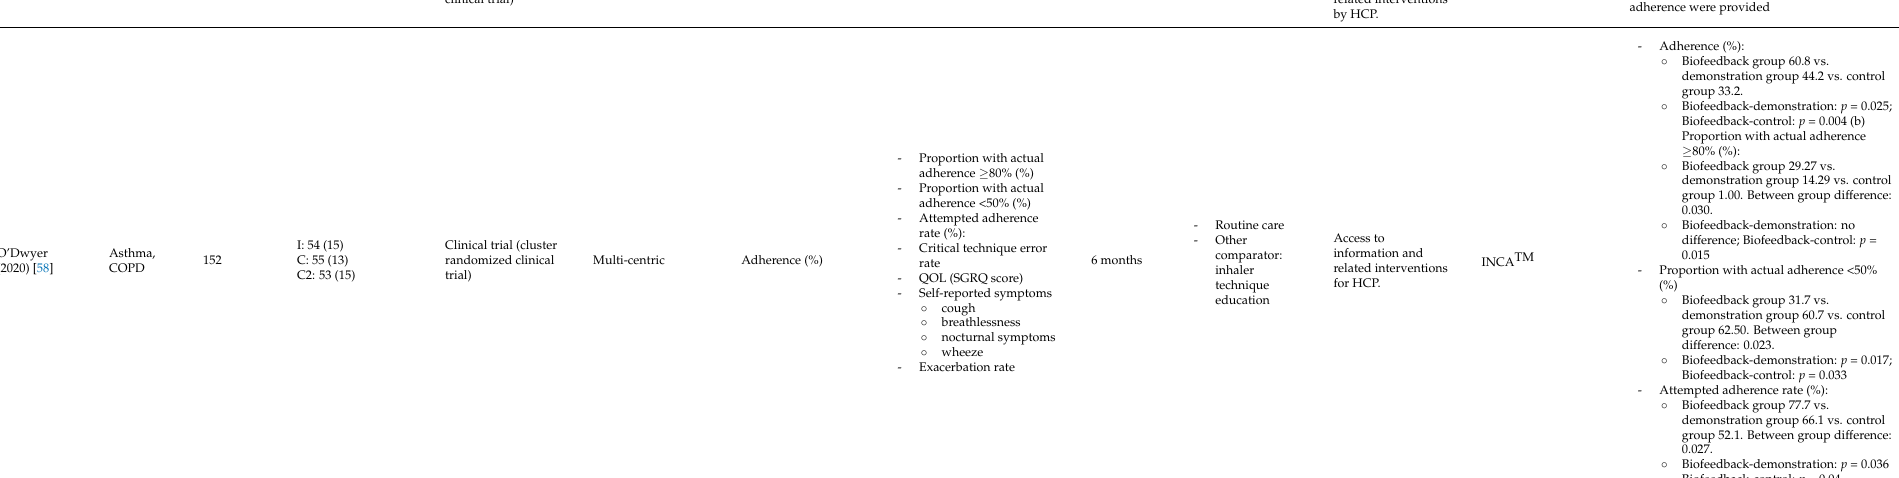
Self-managementfor patients. Accessto information,related interventionsand periodicalreview withpatientsfor HCP.